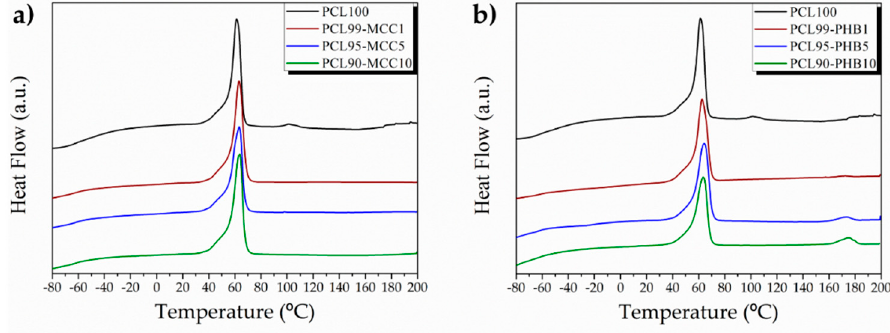
Figure 5. DSC curves of the first heating scan of electrospun ( a ) PCL-MCC and ( b ) PCL-PHB mats.